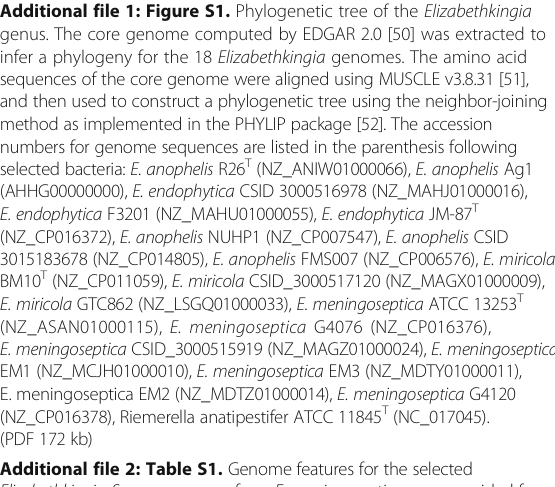
Additional file 2: Table S1. Genome features for the selected Elizabethkingia . Seven genomes from E. meningoseptica were provided for comparison of size, gene count, CRISPR, GC and coding count. (XLS 21 kb) Abbreviations ANI: Average nucleotide identities; CDC: Cholesterol-dependent cytolysin; IMG/MER: Integrated Microbial Genomes and Microbiome Samples Expert Review; MALDI-TOF: Matrix assisted laser desorption-ionisation time-of-flight; MBL: Metallo- β -lactamase; MIC: Minimum inhibitory concentration; SBA: Sheep blood agar; TSA: Solid trypticase soy